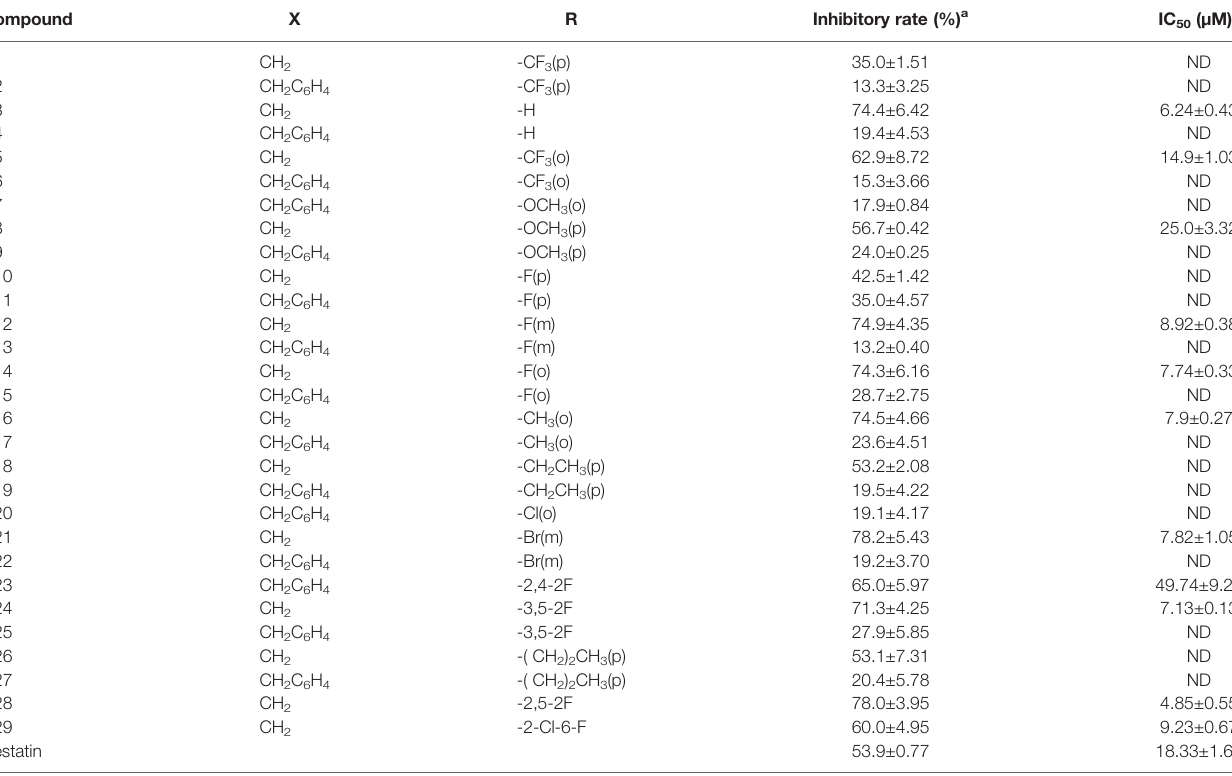
(HDAC6) inhibitors (22), kinesin spindle protein inhibitors, breast cancer resistance protein (ABCG2) inhibitors (23), phosphodiesterase 5 inhibitors (24), transforming growth factor beta (TGF b ) signaling pathway inhibitors (25), and bromodomain and extra terminal proteins (BET) inhibitors (26). The carboline moiety played important roles in the site occupation and hydrophobic interaction of the ligand-receptor complexes. On the other hand, the hydrophobic pocket in the active site of APN requires hydrophobic and bulky fragments for ef fi cient binding. Therefore, in the current study, the tetrahydro- TABLE 1 | Structures and enzyme inhibitory activities of the derived APN inhibitors.